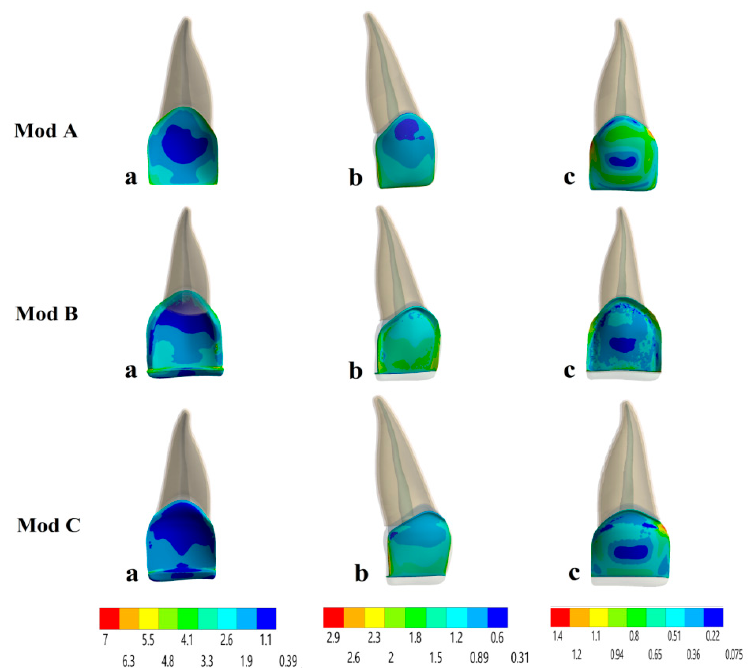
Figure 12. von Mises thermal stress distributions (MPa) in the non-preparation (Mod A), conventional preparation (Mod B) and proposed preparation (Mod C) models due to the hot thermal loading 55 ◦ C on the ( a ) ceramic veneer, ( b ) resin luting cement, and ( c ) adhesive layer. Appl. Sci. 2020 , 10 , x FOR PEER REVIEW